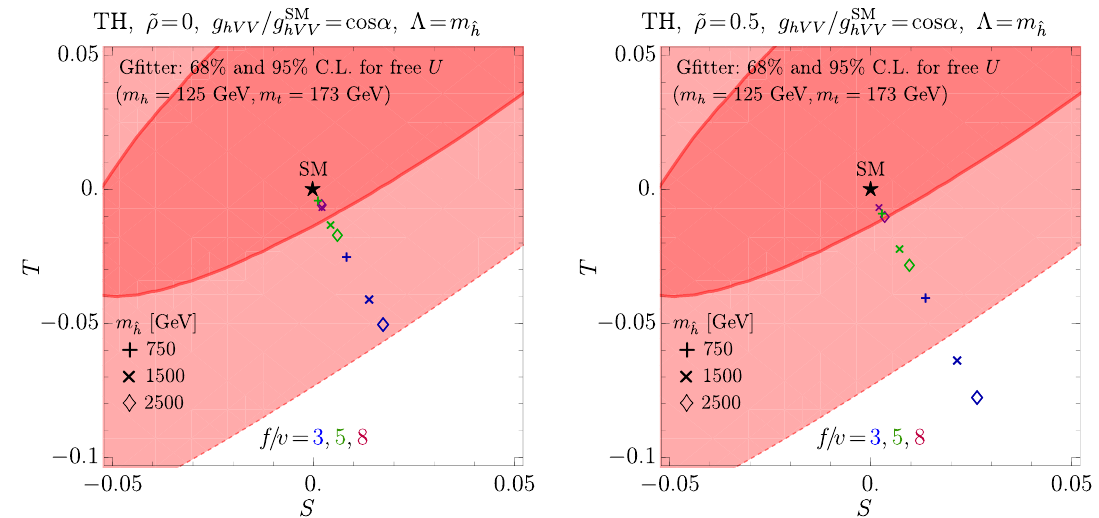
Figure 2 . Magni(cid:12)ed 68% ( red ) and 95% ( light-red ) C.L. contours of the oblique parameters S; T showing contributions of the scalar sector of the TH models for ~ (cid:26) = 0 (left) and ~ (cid:26) = 0 (right). We consider the twin Higgs mass m ^ = (750 ; 1500 ; 2500) GeV denoted as (+ ; (cid:2) ; } ), respectively, for h the color-coded values of f=v = 3 ( blue ), 5 ( green ), 8 ( purple ). (cid:5) Masses of the twin sector gauge bosons m and fermions m scale universally ^ V ^ f